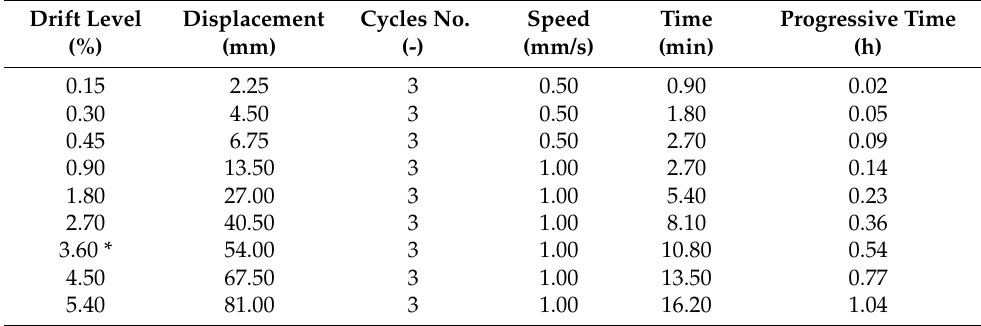
Table 1. Designed test protocol—rectangular pier.